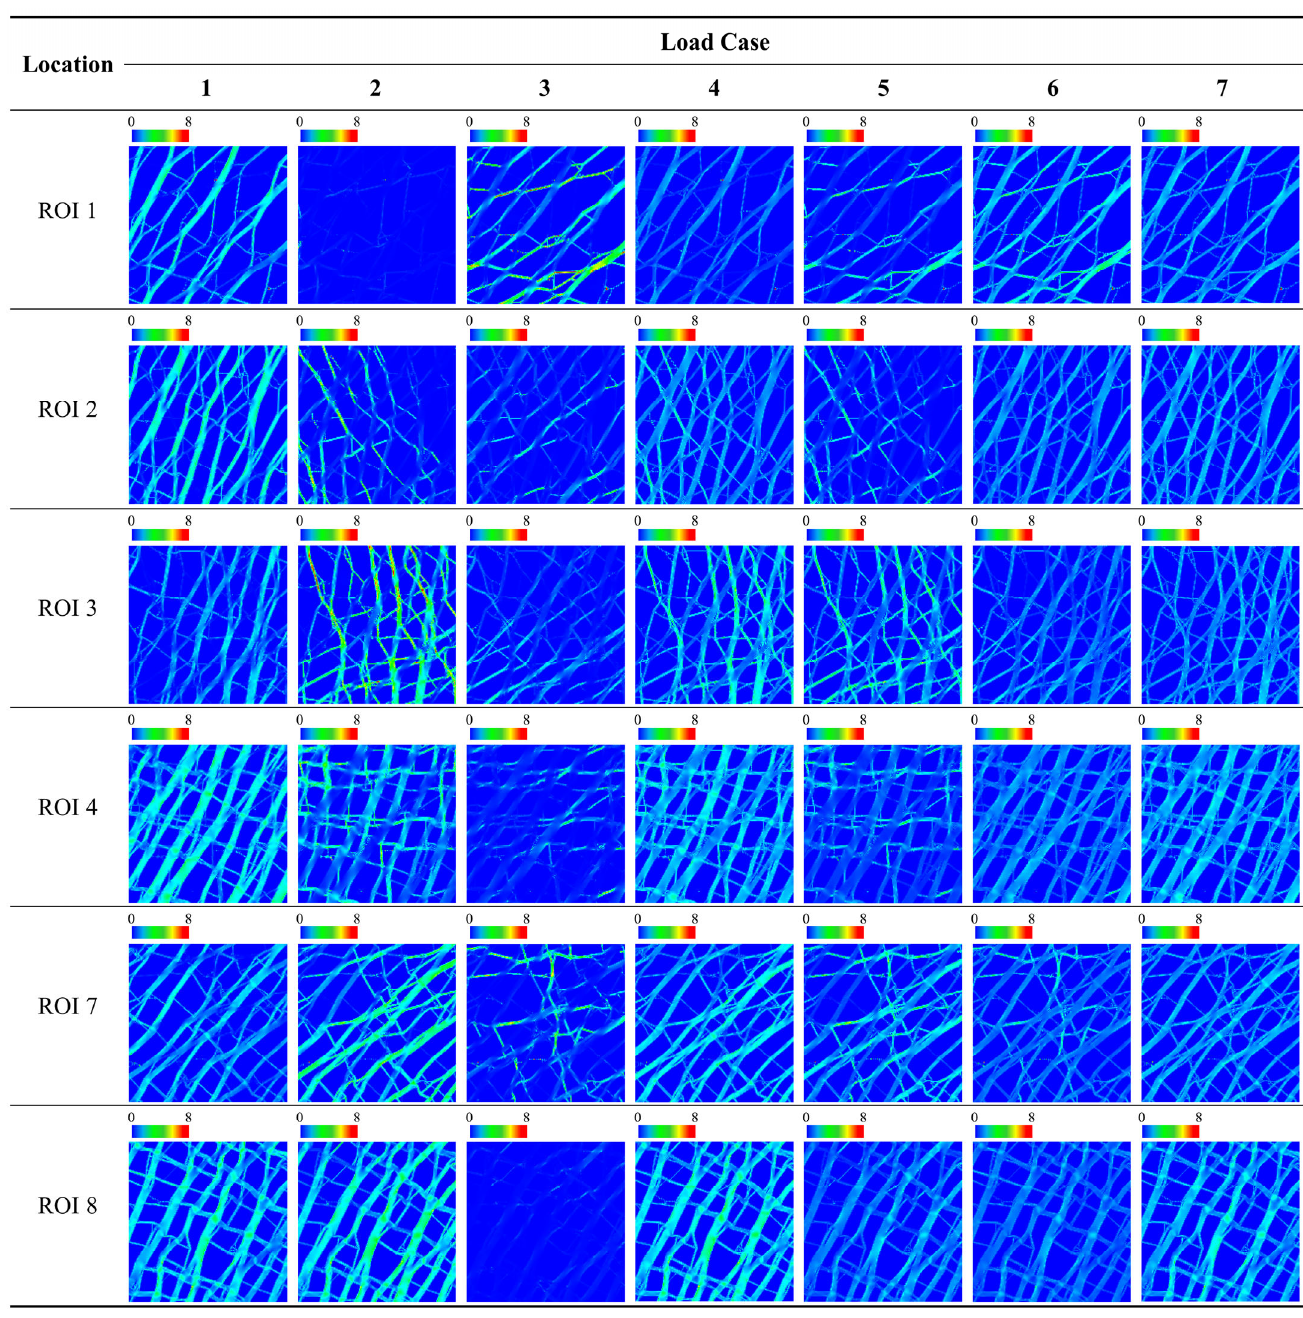
Figure 7. Strain energy density (J/mm 2 ) contour plots for ROIs in the epiphysis for each load